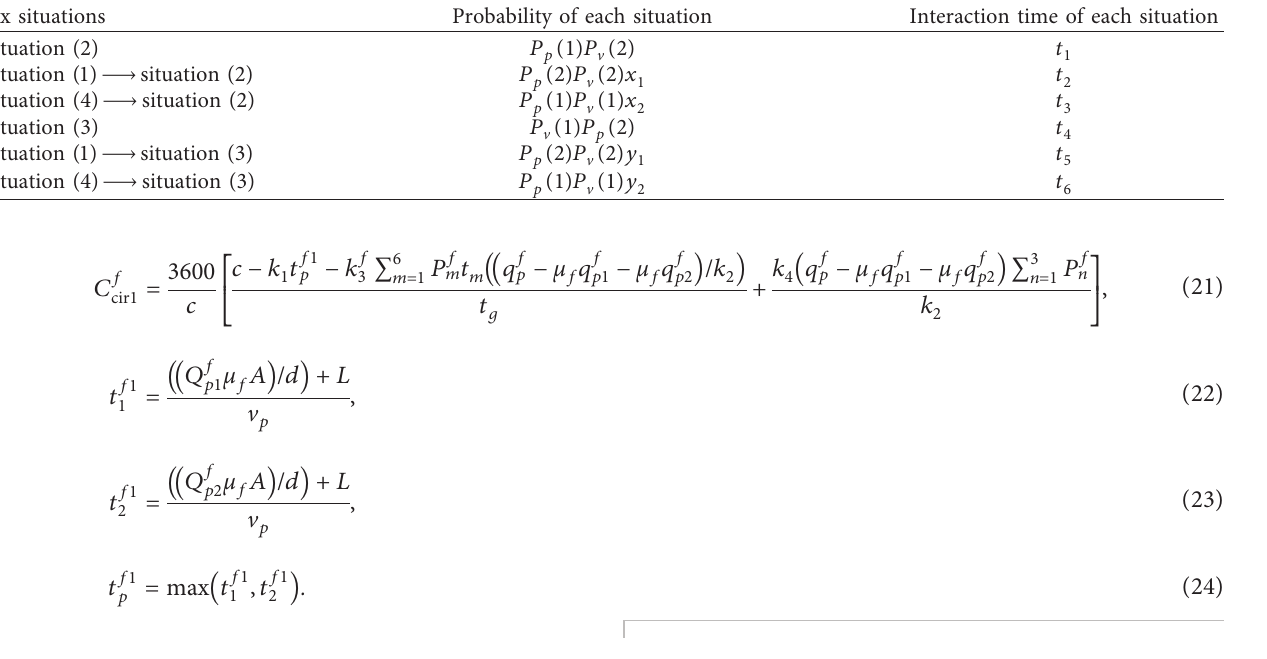
Table 5: Six situations of pedestrian-vehicle interaction and their corresponding